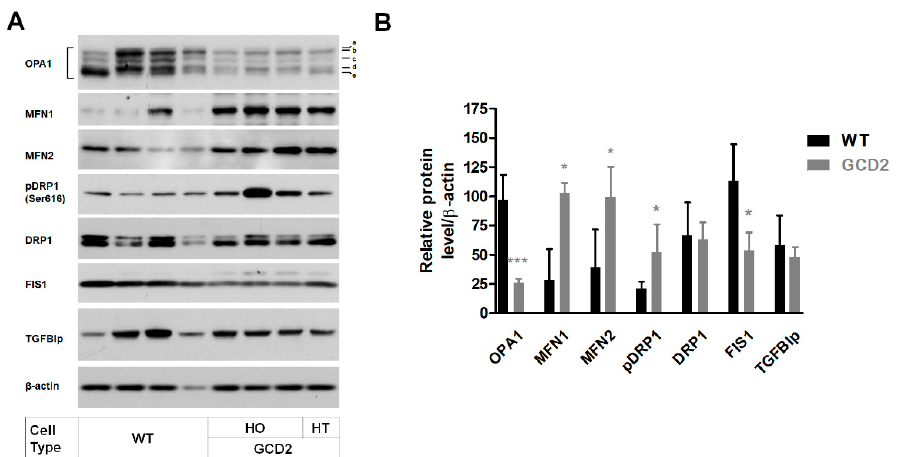
Figure 2. Mitochondrial fusion/fission-related protein levels. ( A ) A representative Western blot image for key mitochondrial dynamics proteins. OPA1 is regulated by complex patterns of proteolysis and alternative splicing. The OPA1 band patterns (a-, b-, c-, d-, and e-form) were expressed in WT and GCD2 corneal fibroblasts. ( B ) Graphs on the right show quantifications of different protein levels normalized to actin. OPA1 and FIS1 levels were significantly decreased in GCD2 corneal fibroblasts compared with those in control subjects, as were FIS1 protein levels. In contrast, MFN1, MFN2, and pDRP1 protein levels were significantly increased in GCD2 corneal fibroblasts compared with those in control cells. TGFBIp level was not significantly different between GCD2 and WT corneal fibroblasts. Error bars indicate mean ± SD. * p < 0.05 and *** p < 0.001.